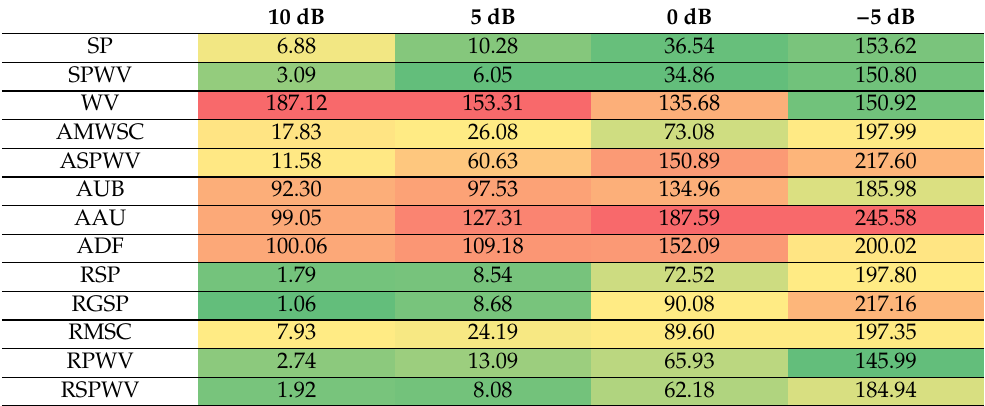
Table 3. Estimation of IF MSE for a noisy mono-component sinusoidal FM signal for different SNR levels (averaged over 100 noise realizations), cell colors range from green for the best result to red for the worst result in each column respectively, 1 × 10 − 4